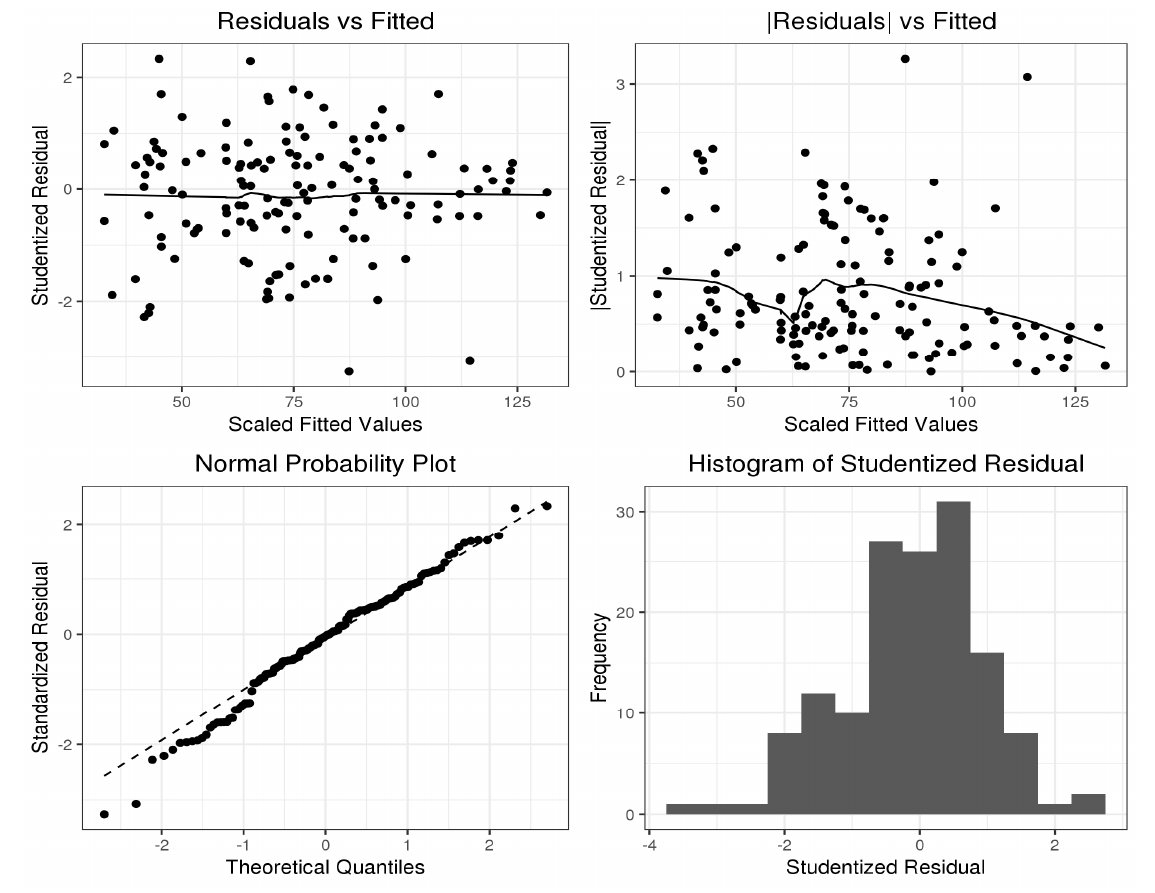
Figure 7. Plots of TSP Gamma model